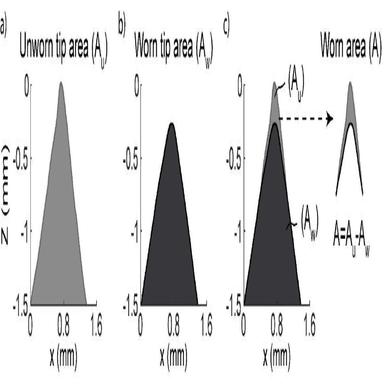
Determination of the wear of a M2 standard tool steel blade using 3D laser confocal microscope. a) Tip area of the middle section of an unworn blade, b) Tip area of the middle section of a worn blade after the knife mill test. c) Worn blade area determined as the differential between the unworn and worn blade tips.